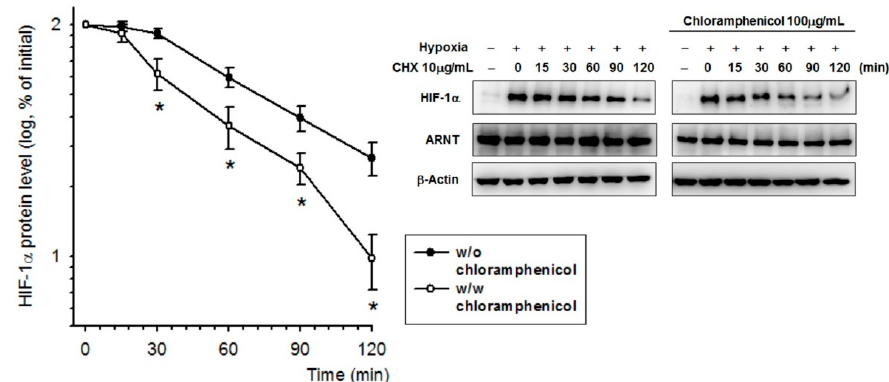
Figure 3. Chloramphenicol destabilized the HIF-1 α protein. HIF-1 α is a short-lived protein. A